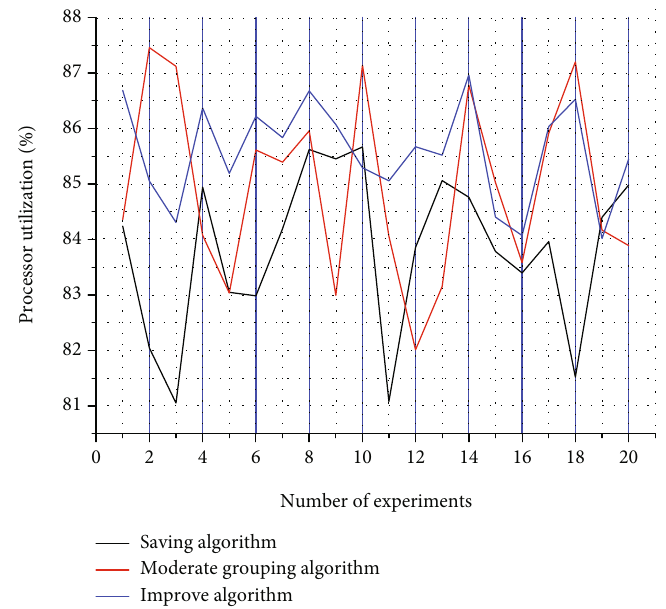
Figure 4: Processor utilization of the algorithm.